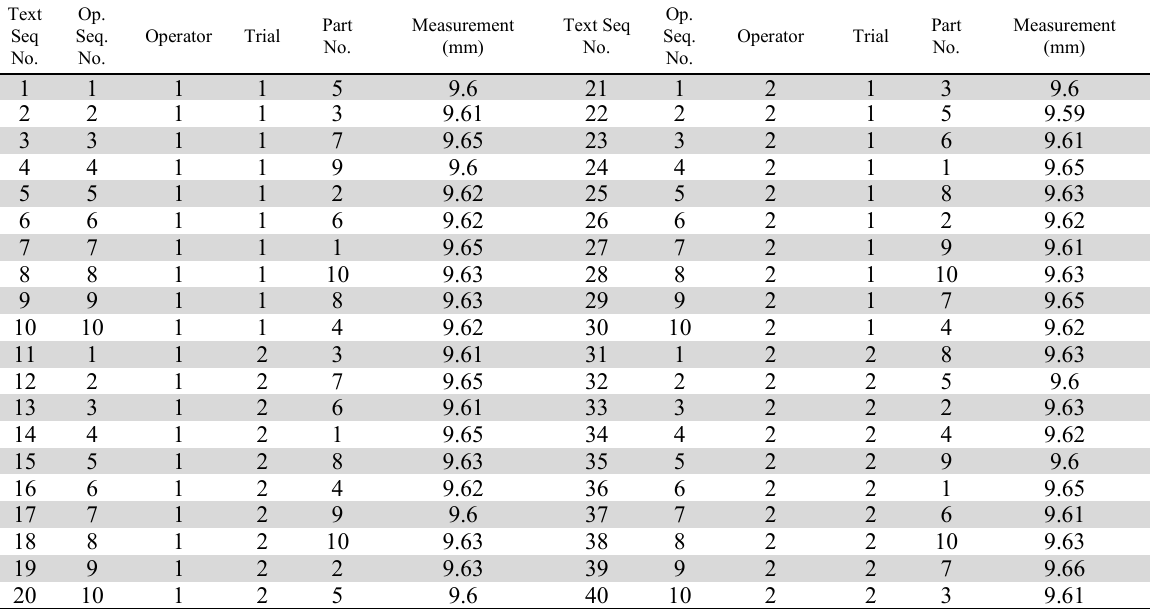
Measurement System